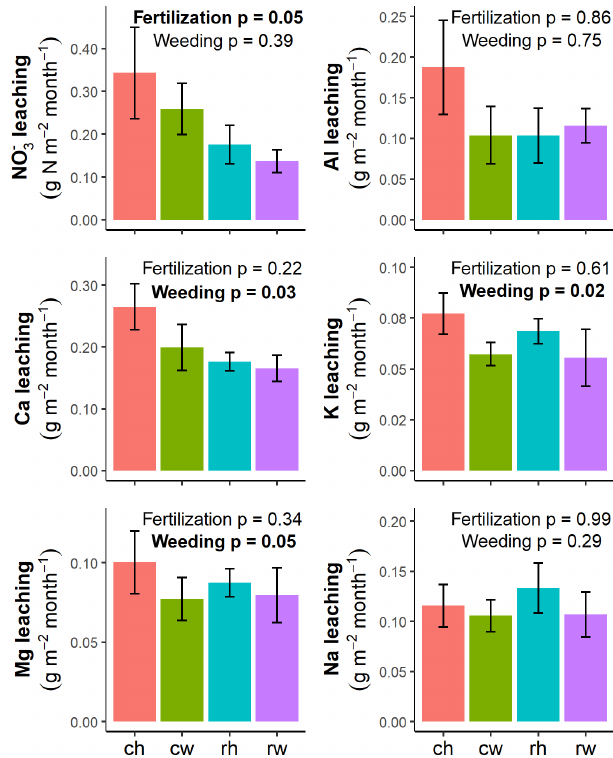
Figure 5. Average monthly leaching losses at 1.5m depth for each experimental treatment from March 2017 to February 2018 (means ± standard errors, n = 4 plots). Effects of fertilization and weeding were evaluated using linear mixed effects models with monthly sampling as the random effect and plots nested by man- agement zone with subplot as the random effect; there was no significant effect of fertilization and weeding interaction. Treat- ments: ch is conventional fertilization–herbicide, cw is conven- tional fertilization–mechanical weeding, rh is reduced fertilization– herbicide, and rw is reduced fertilization–mechanical